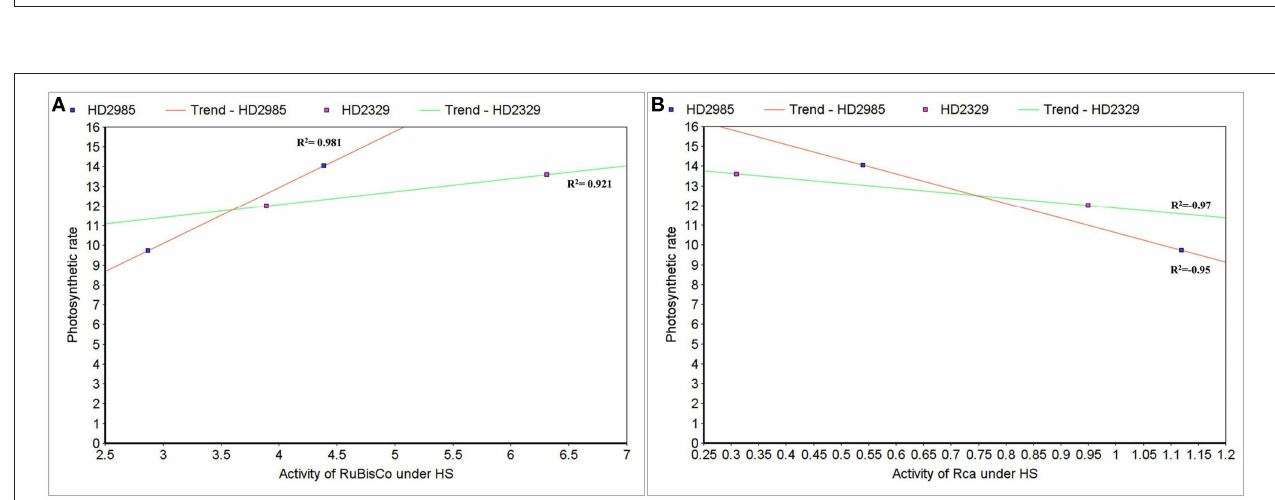
FIGURE 12 | Cluster-map for analyzing the correlation between expression and activity of RuBisCo activase (Rca) and RuBisCo under control and heat stress conditions. (A) Correlation between the expression and activity of Rca in Halna and PBW621 (C and HS), (B) Correlation between the expression and activity of Rca in HD2985 and HD2329 (C and HS), (C) Correlation between the activity of Rca and RuBisCo in Halna (C and HS), (D) Correlation between the expression and activity of Rca and RuBisCo in PBW621 (C and HS); C—22 ± 3 ◦ , heat stress—42 ◦ C for 2h.